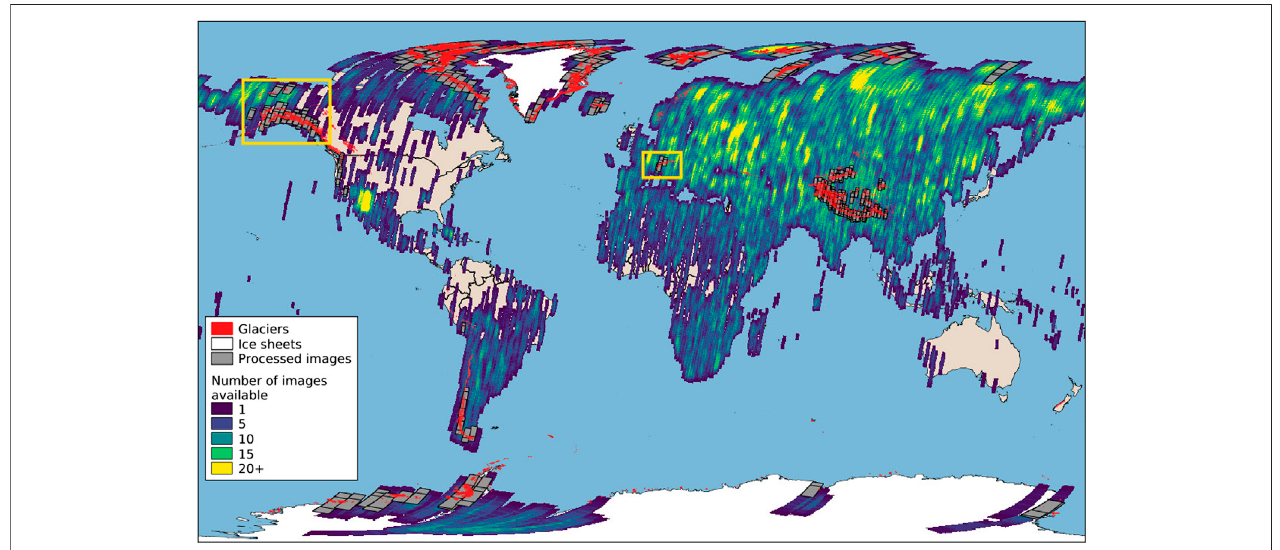
FIGURE 1 | Map showing the number of KH-9 MC images available in the USGS archive (color scale), the 698 images preprocessed in this study (gray, Section 2.3 ), glacier outlines from RGI v6.0 (red), and outlines for the two study areas in Alaska and European Alps (yellow rectangles).